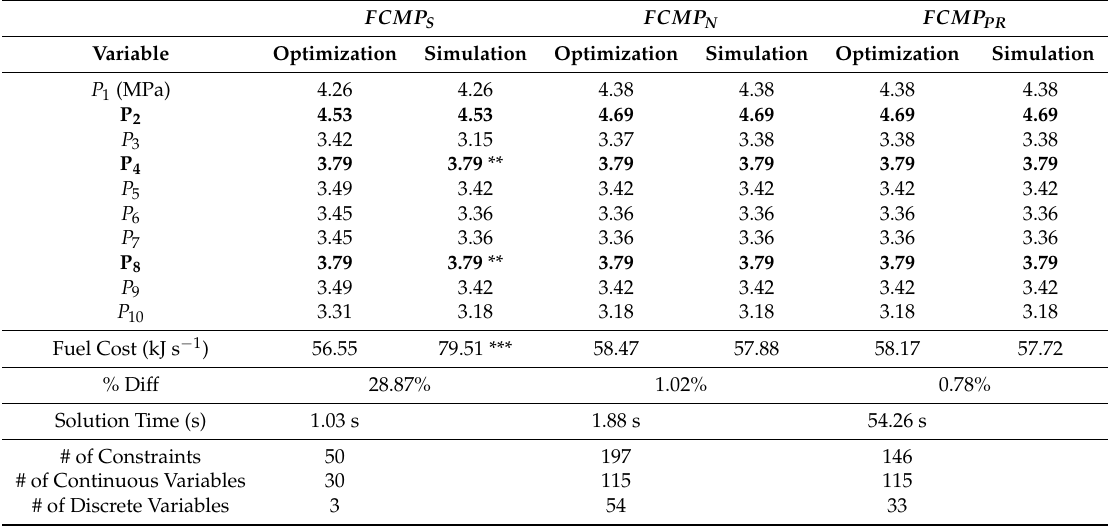
Table 4. Example 2 case study results. All three compressor stations only have one unit active in all three model solutions. Lines in bold represent outlet pressures from compressor stations.